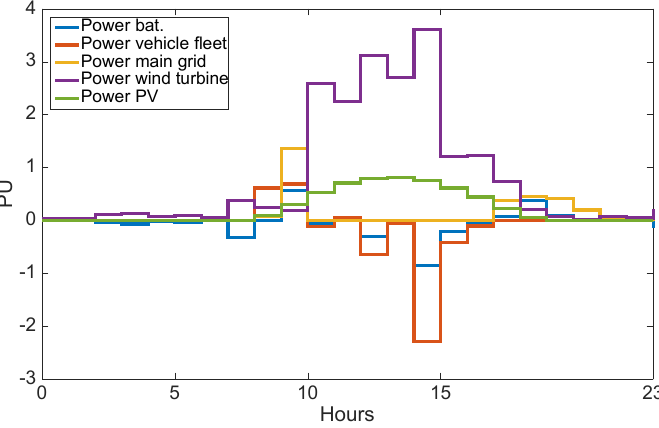
Figure 9. Result of the power in generators for a clear summer day.